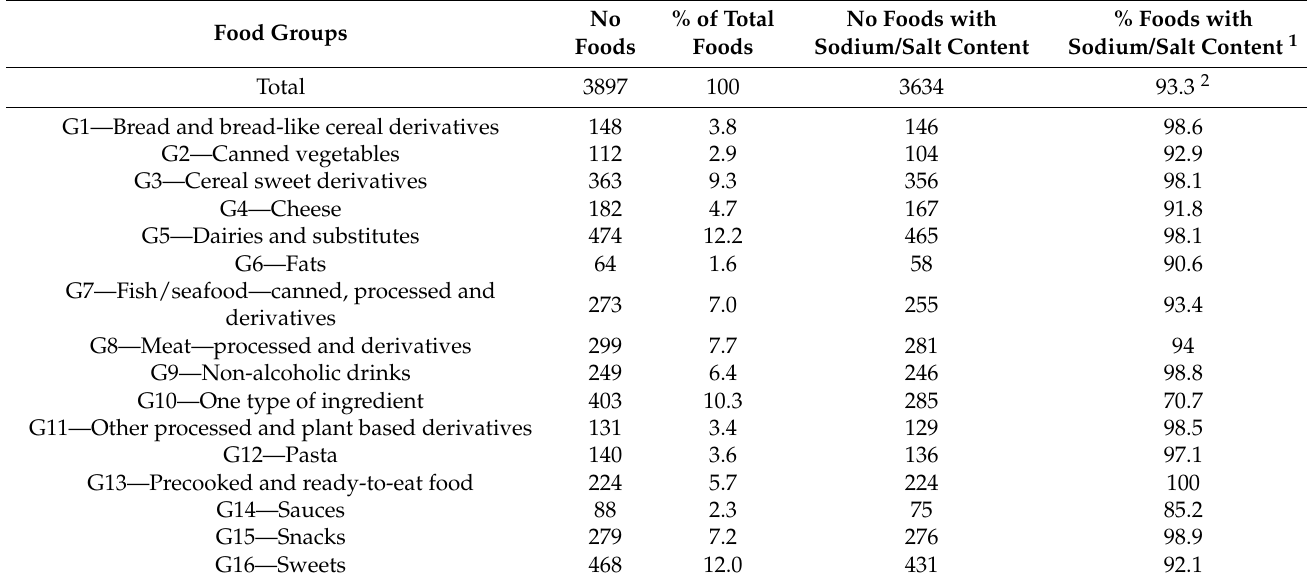
Table 2. Foods included in the study and foods with sodium/salt content